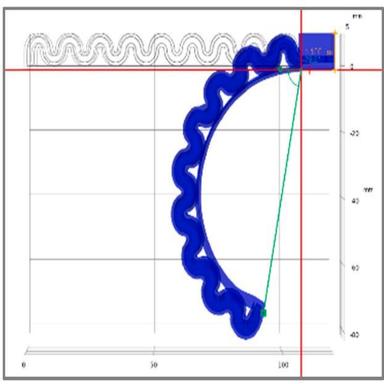
Displacement analysis (15 psi).